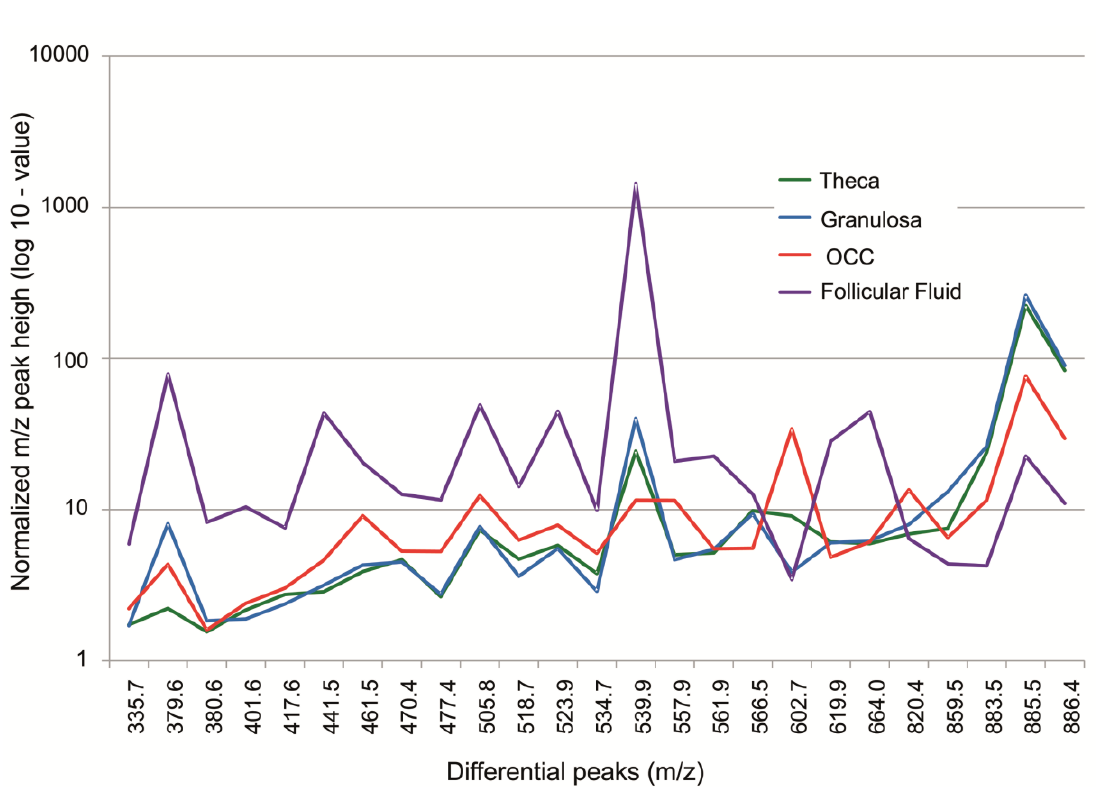
Figure 6. Comparative analysis of the 25 lipid species that differed most among follicular compartments detected by MALDI MSI in positive and negative ion mode. Log-values of normalized peak heights of the ions detected in follicular fluid, theca, granulosa and oocyte-cumulus complex (OCC) of individual follicles are